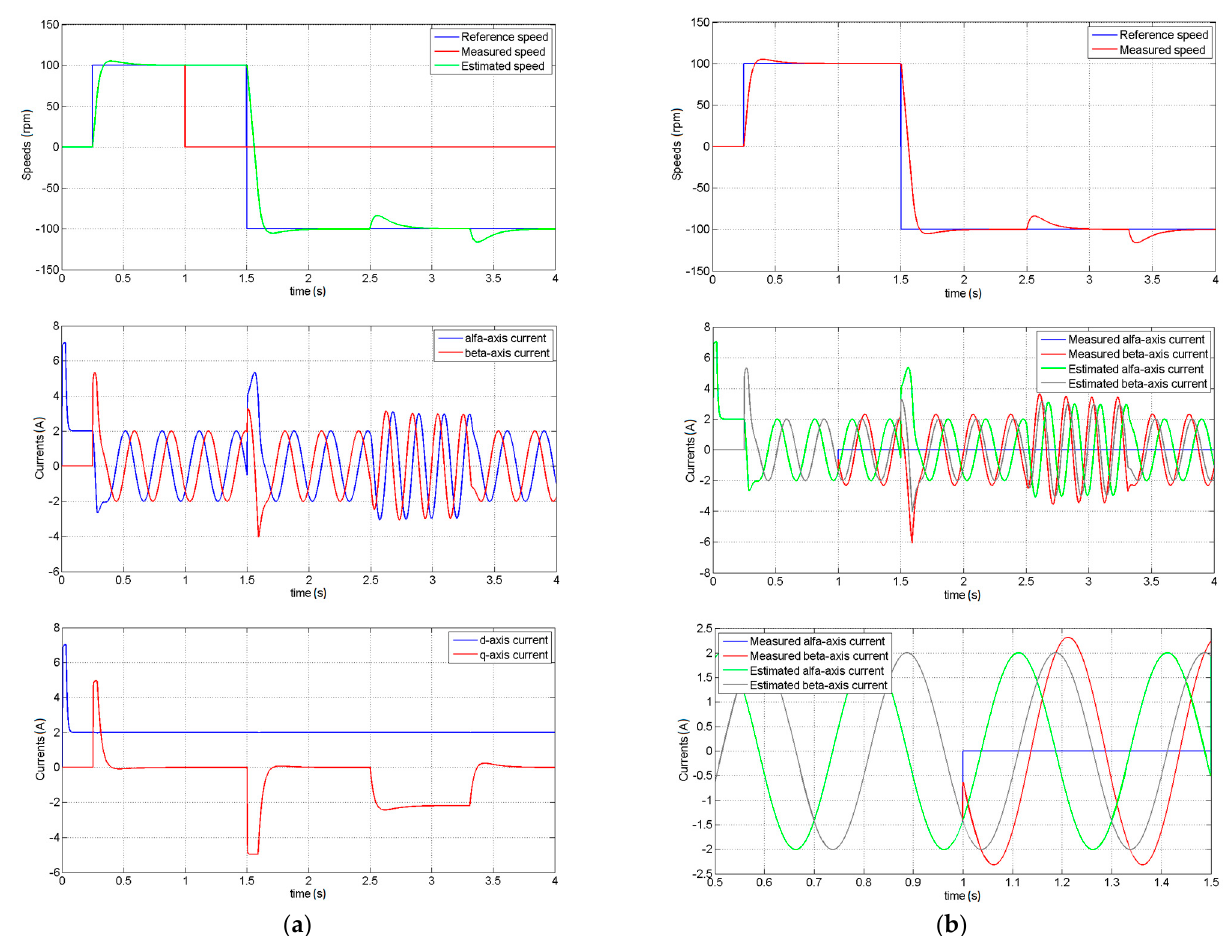
Figure 5. Simulation results: Simulated scenario—motor excitation, acceleration from 0 to 100 rpm, speed reversal to − 100 rpm, step changes of load torque from 0 to − 5 Nm at 2.5 s and from − 5 to 0 Nm at 3.3 s; ( a ) rotor speed sensor fails at 1 s, drive passes to speed sensorless control using estimated rotor speed.; ( b ) a-phase stator current sensor fails at 1 s, drive passes to current sensorless control using estimated stator currents.